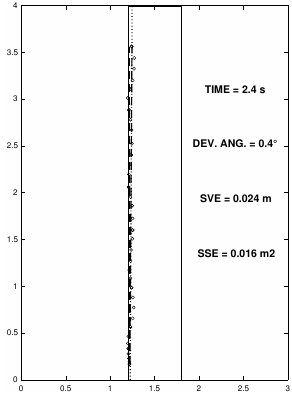
Figure 7. Participant B’s post-test veering path walked in the shortest time (2.4 s)